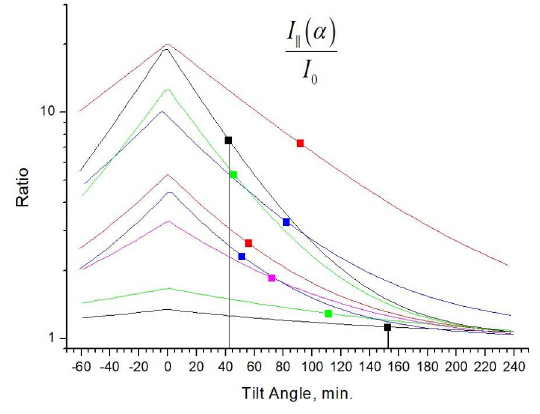
Fig. 4. Different cases of observed distributions I Fig. 3. Dependence of the signal intensity on the tilt angle All data measured on June 02, 2018 well described by the exponential distribution (red line in Fig. 3), where w determines the indicates the width of the distribution, and α 0 error of the lidar targeting to vertical. For Fig. 3a w =42 ′ , for Fig. 3b w =82 ′ . The shift of the curve maximum is less than 2 minutes, which indicates a good orientation of the lidar to the zenith.